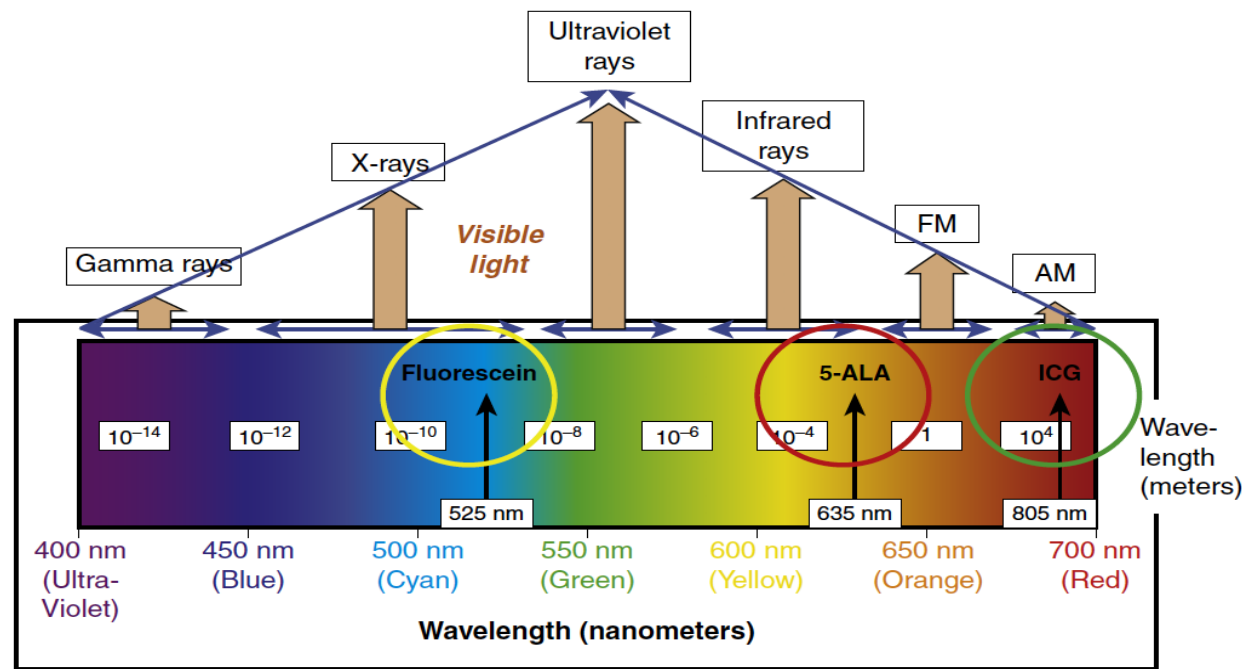
Figure 1. Fluorescence emission wavelengths of the most commonly used fluorophores used in glioma surgery. 5-ALA, 5-aminolevulinic acid; ICG, indocyanine green; FM, Frequency Modulation; AM, Amplitude Modulation. (Permission from Hadjianapyis CG, Stummer W. Fluorescence Guided Neurosurgery. New York: Thieme Medical Publishers; 2018) [5].